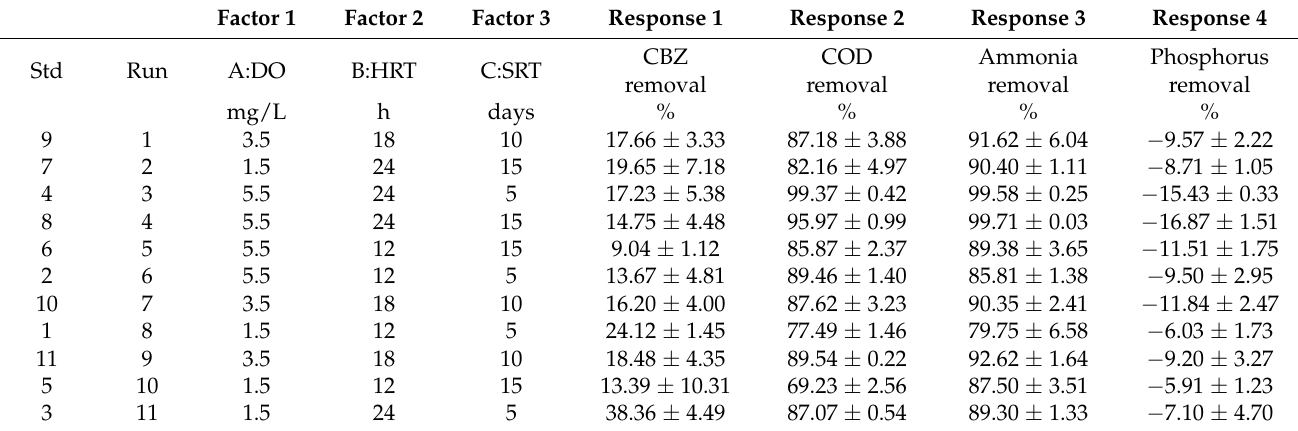
Table 3. Experimental design table for the factors and